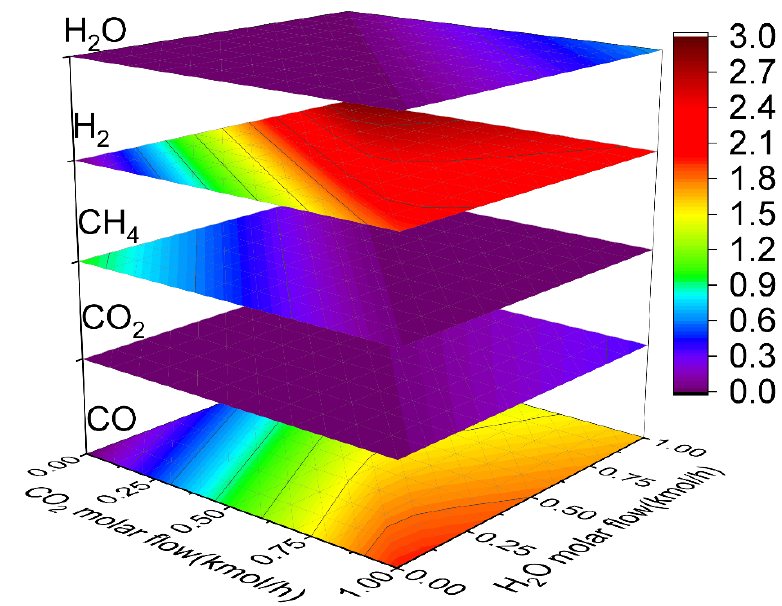
Figure 2. Effects of steam and CO 2 flowrates on gaseous products.